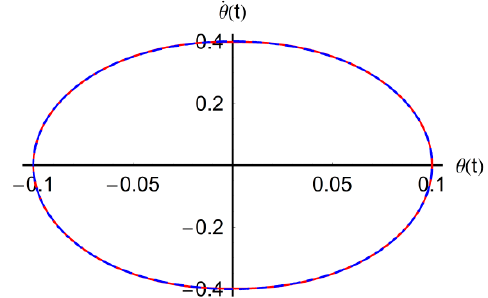
Figure 21. Phase plane for A = 0.4, L = 0.6. Figure 5. Phase plane for A = 0.1, a = 0.4, L = 0.6 _____ numerical_ _ _ _approximate solution (40). Figure 5. Phase plane for A = 0.1, a = 0.4, L = 0.6 approximate solution (50).